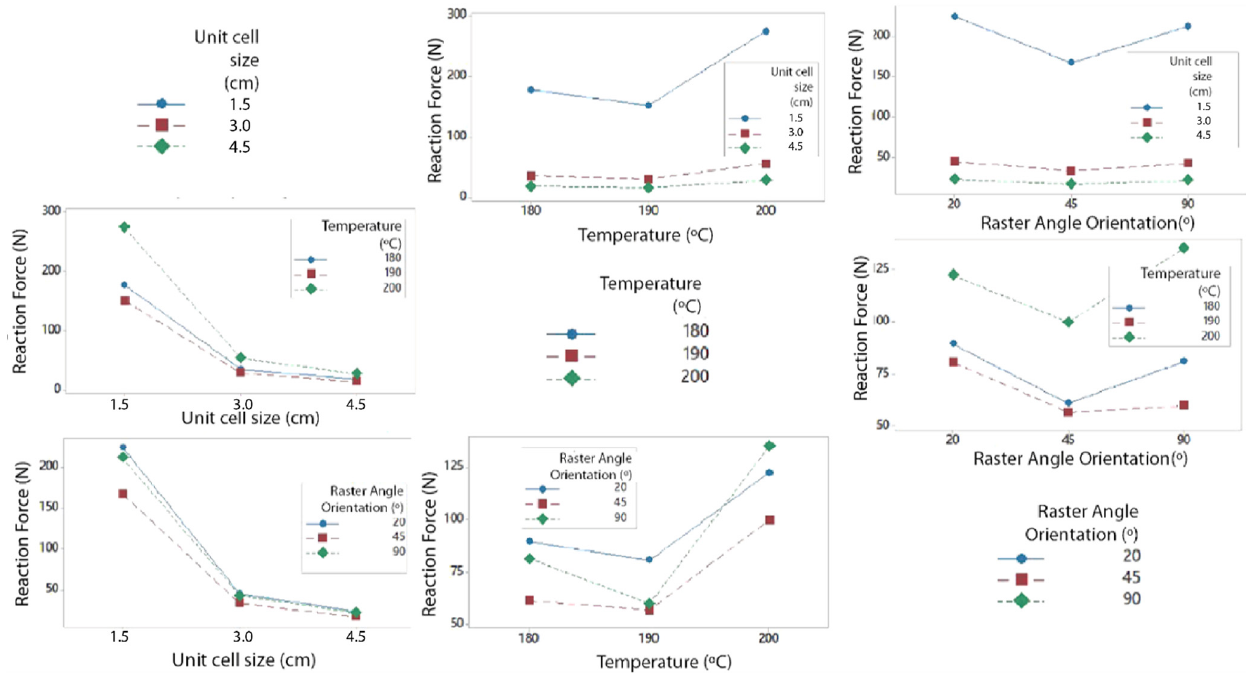
Figure B2. Interaction graph for BCCz.